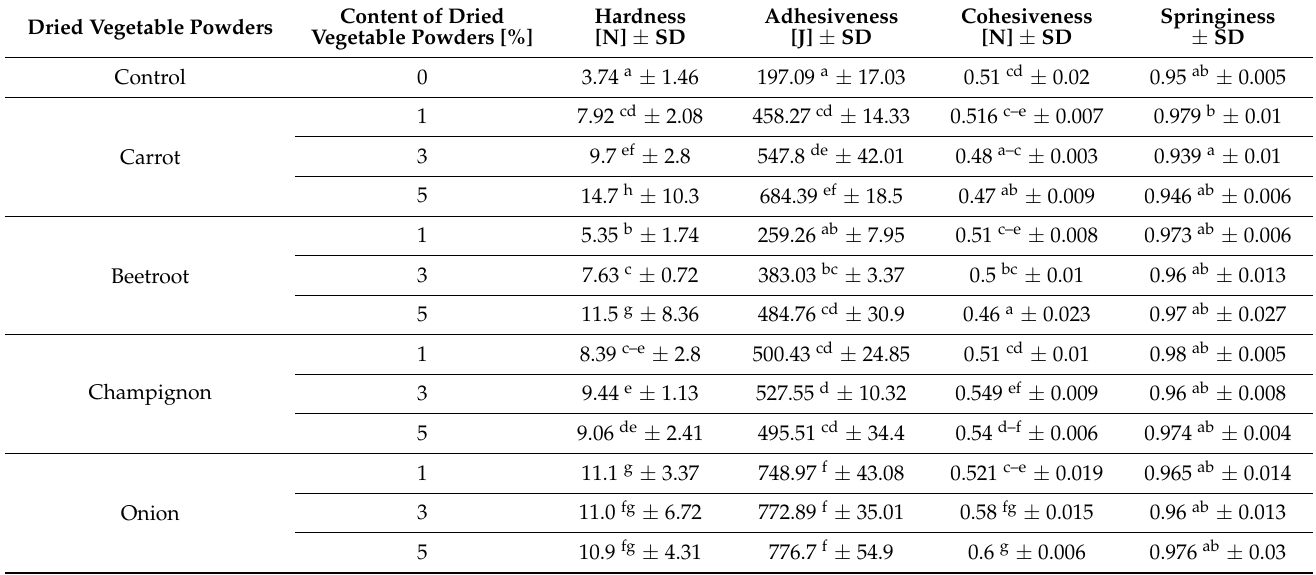
Table 2. Effect of different dried vegetable powders content on the textural properties of fat-free dairy